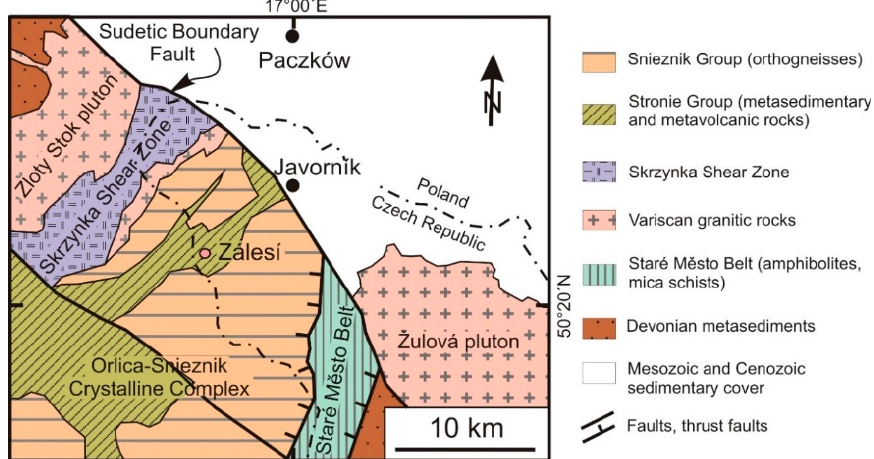
Figure 5. Geological position of the Zálesí uranium deposit (modified from Dolní č ek et al. [32]).